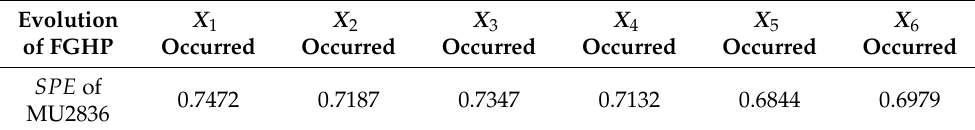
Table 5. Single FGHP performance evaluation value with node updating (from X 1 to X 6